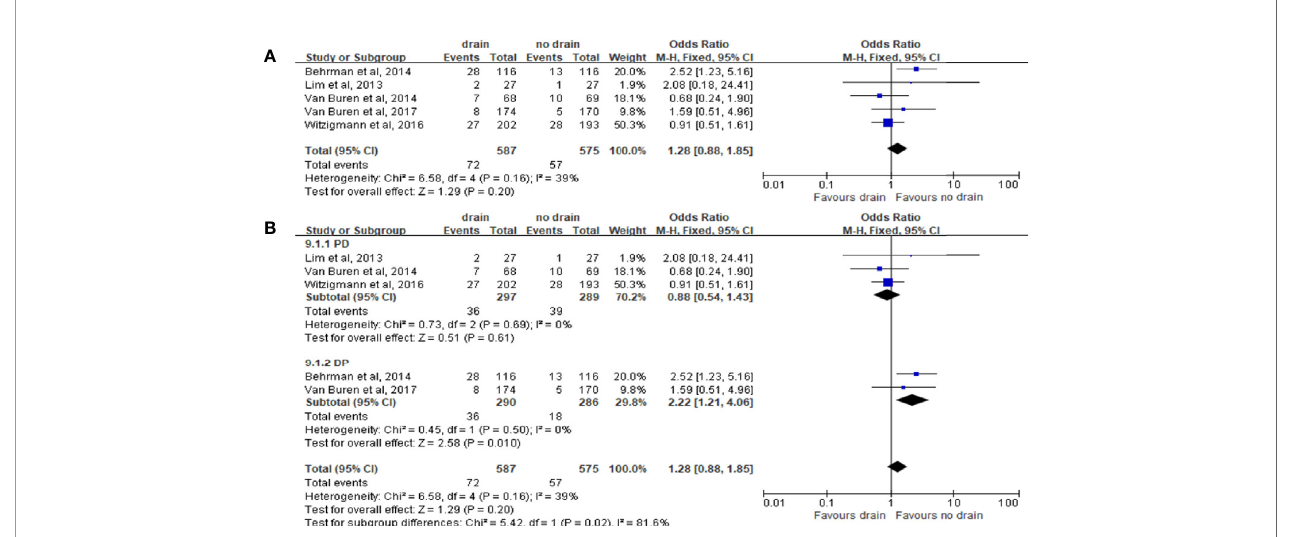
FIGURE 11 | Forest plot of the comparison of the rate of wound infection in drain versus no-drain groups after pancreatic resection. (A) Comparison in overall; (B) comparison in PD and DP subgroups,